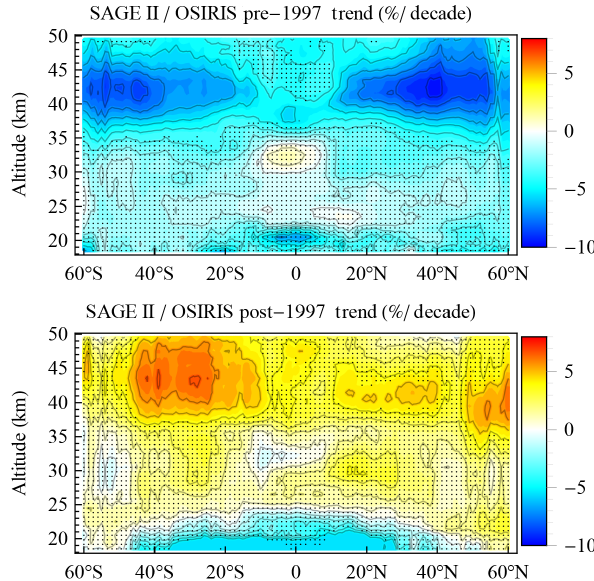
Figure 10. Altitude–latitude cross section of linear ozone trends in percent per decade before 1997 (top) and after 1997 (bottom) de- rived from the merged SAGE II and OSIRIS ozone anomaly time series. Statistical significance at the 95% level is denoted by areas without grey stippling. Significant recovery is observed throughout the majority of the stratosphere, except below approximately 22km altitude between 40 ◦ S and 40 ◦ N where decreasing trends continue and in the tropics between 25 and 35km where there is no signifi- cant trend.